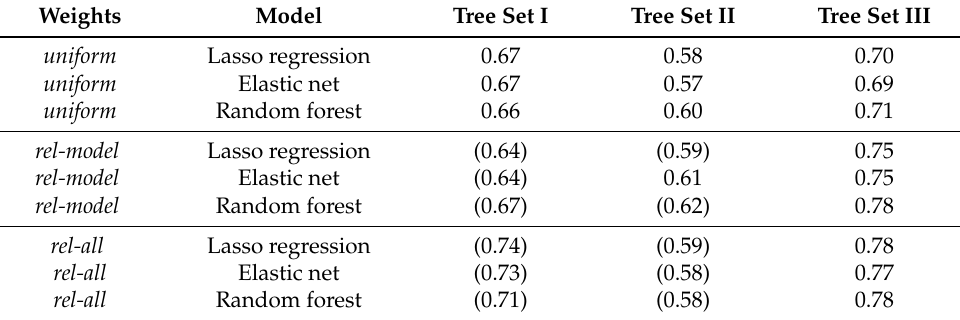
Table 1. Accuracy for different tree sets, weights, and CAFPA prediction models. Numbers in parentheses indicate that the choice of weights was not based on Y90 combinations but on one single CAFPA combination (cf. Figure